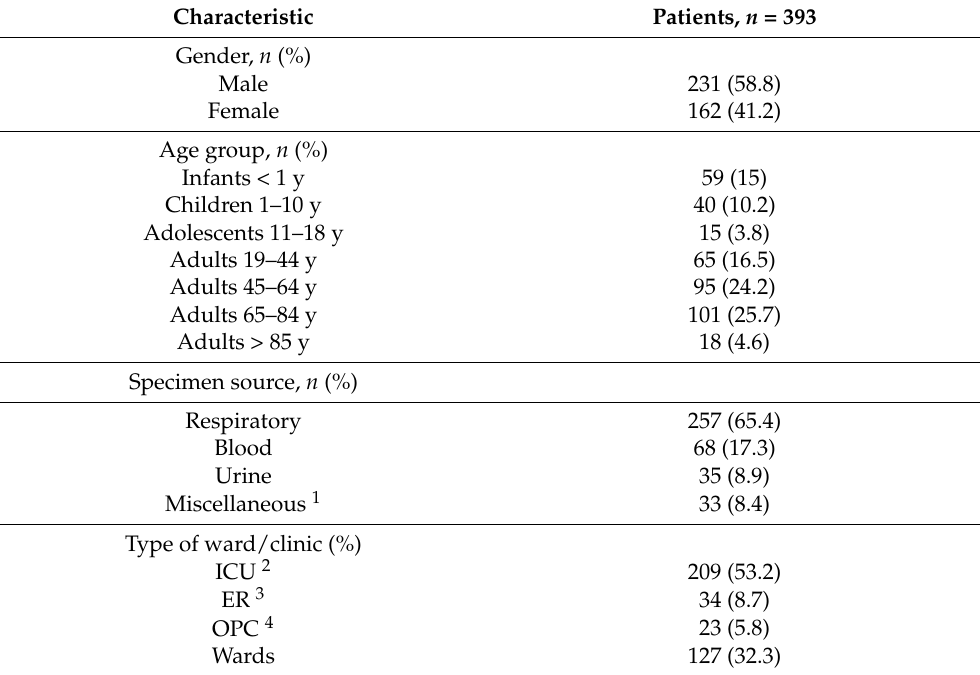
Table 1. Demographic characteristics of patients with S. maltophilia infections.